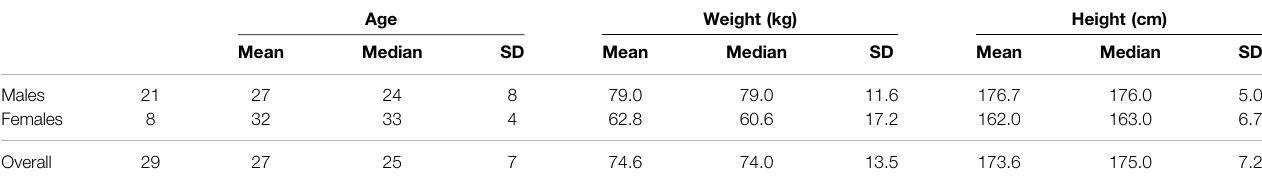
TABLE 1 | Statistics of the